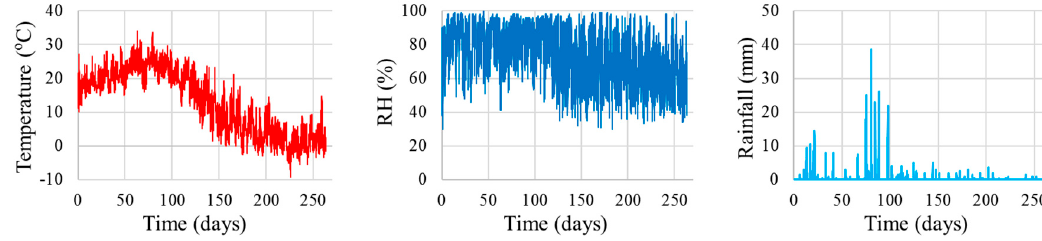
Figure 20. FE model of one-fourth of the span of Shinkesen Bridge.